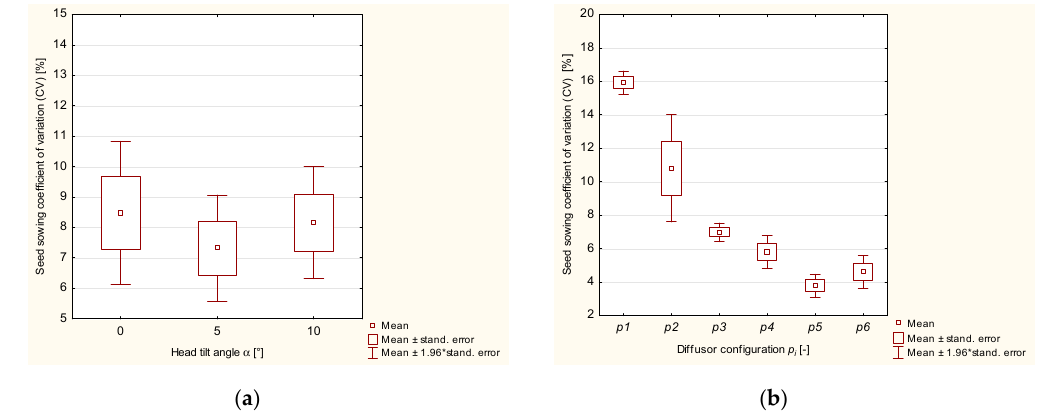
Figure 11. Variability of the coefficient of variation (CV) for rye seeds sowing evenness depending on: ( a ) the head tilt angle, ( b ) the diffuser variant (the configuration and number of diffusion rings) Further statistical analysis involved answering the question of whether the mean values of the coefficient of variation ( CV ) differed significantly depending on the seed species. One-way analysis of variance (ANOVA) was applied with null hypothesis H 0 that the mean values of the coefficient of variation ( CV ) were equal and alternative hypothesis H 1 that the mean values of the coefficient of variation were not equal. The analysis of variance (Table 3) showed that hypothesis H 0 about the equality of the mean values of the coefficient of variation should be rejected in favor of alternative hypothesis H 1 about the lack of equality of the mean values of the coefficient of variation. As a result of the data in Table 3, the mean value of the coefficient of variation ( CV ) for rye seeds ( CV = 7.99%) was significantly lower, i.e., by nearly 34% (tatistically significant difference at a significance level α = 0.01) than the mean value of the coefficient of variation for oat seeds ( CV = 12.05%). Like the previous statistical analysis, the results of the analysis of variance shown in Table 3 are also illustrated in Figure 12 for greater clarity. Table 3. The analysis of variance of the coefficient of variation ( CV ) for sowing evenness depending on the seed species No. Seed Species